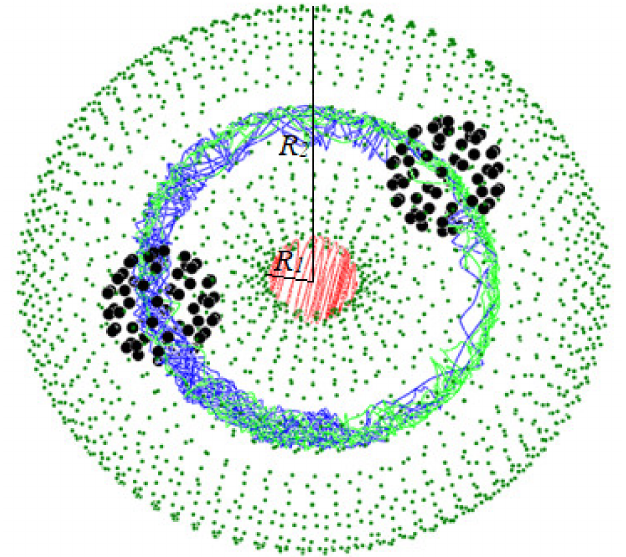
Figure 1. Unstable rotation of a tor-fullerene molecular structure. The red line shows the trajectory of one of the nanotorus atoms.